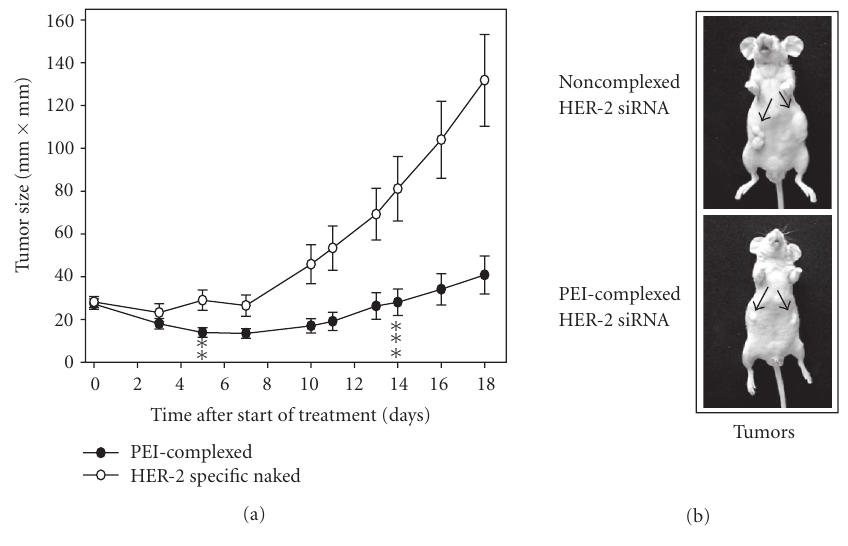
Figure 4: Systemic treatment of mice with PEI-complexed HER-2-specific siRNAs leads to reduced growth of subcutaneous SKOV-3 tumor xenografts due to decreased HER-2 expression. In [70] athymic nude mice bearing subcutaneous tumor xenografts were injected IP with 0.6 nmoles HER-2-specific naked (open circles) or PEI-complexed (closed circles) siRNAs 2–3 times per week and tumor sizes were evaluated daily from the product of the perpendicular diameters of the tumors. Mean +/- standard error of the mean (SEM) is depicted and Student’s unpaired t test was used for comparisons between data sets ( ∗∗ P < . 03, ∗∗∗ P < . 01). Di ff erences in tumor growth reach significance at day 5 indicating the antitumoral e ff ects of the PEI-complexed HER-2-specific